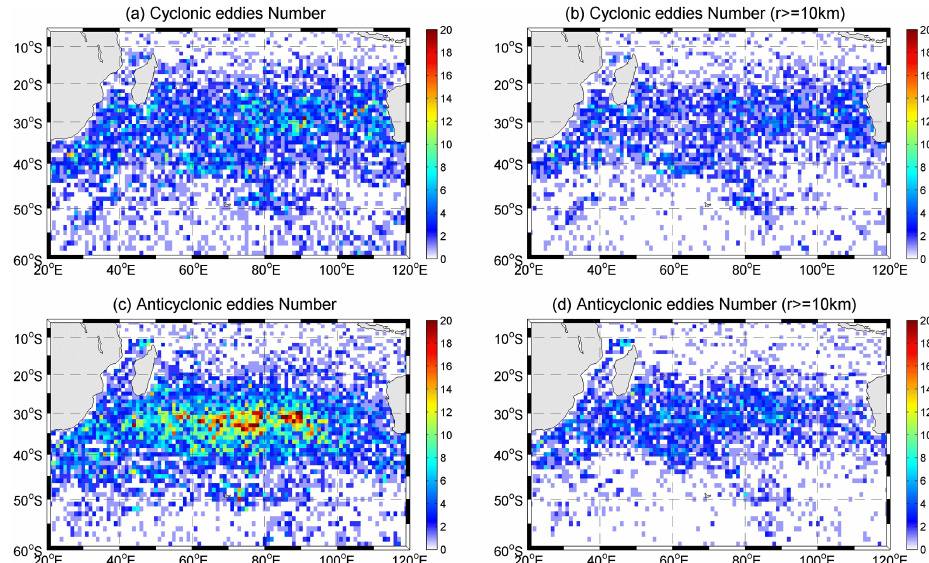
Figure 8. (a) Number of cyclonic eddies detected in 1 ◦ × 1 ◦ bins. (b) Number of cyclonic eddies with radii equal or greater than 10km